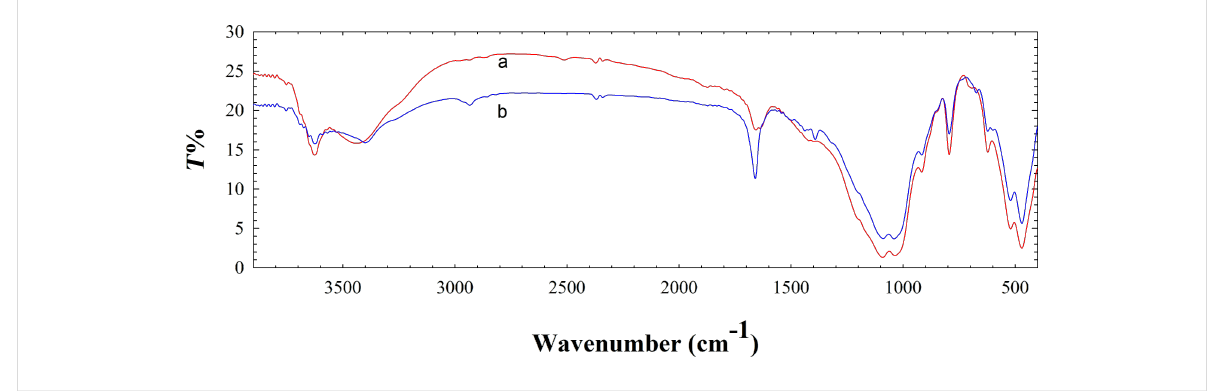
Figure 2: FTIR spectra of (a) natural bentonite and the (b) Cu NPs/bentonite composite.